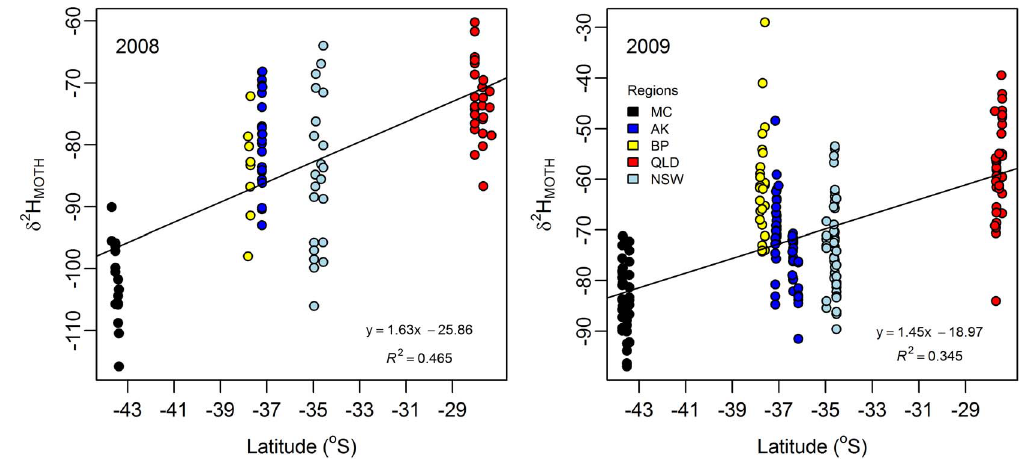
Figure 4. Relationship between H.armigera wing d 2 H values and latitude.